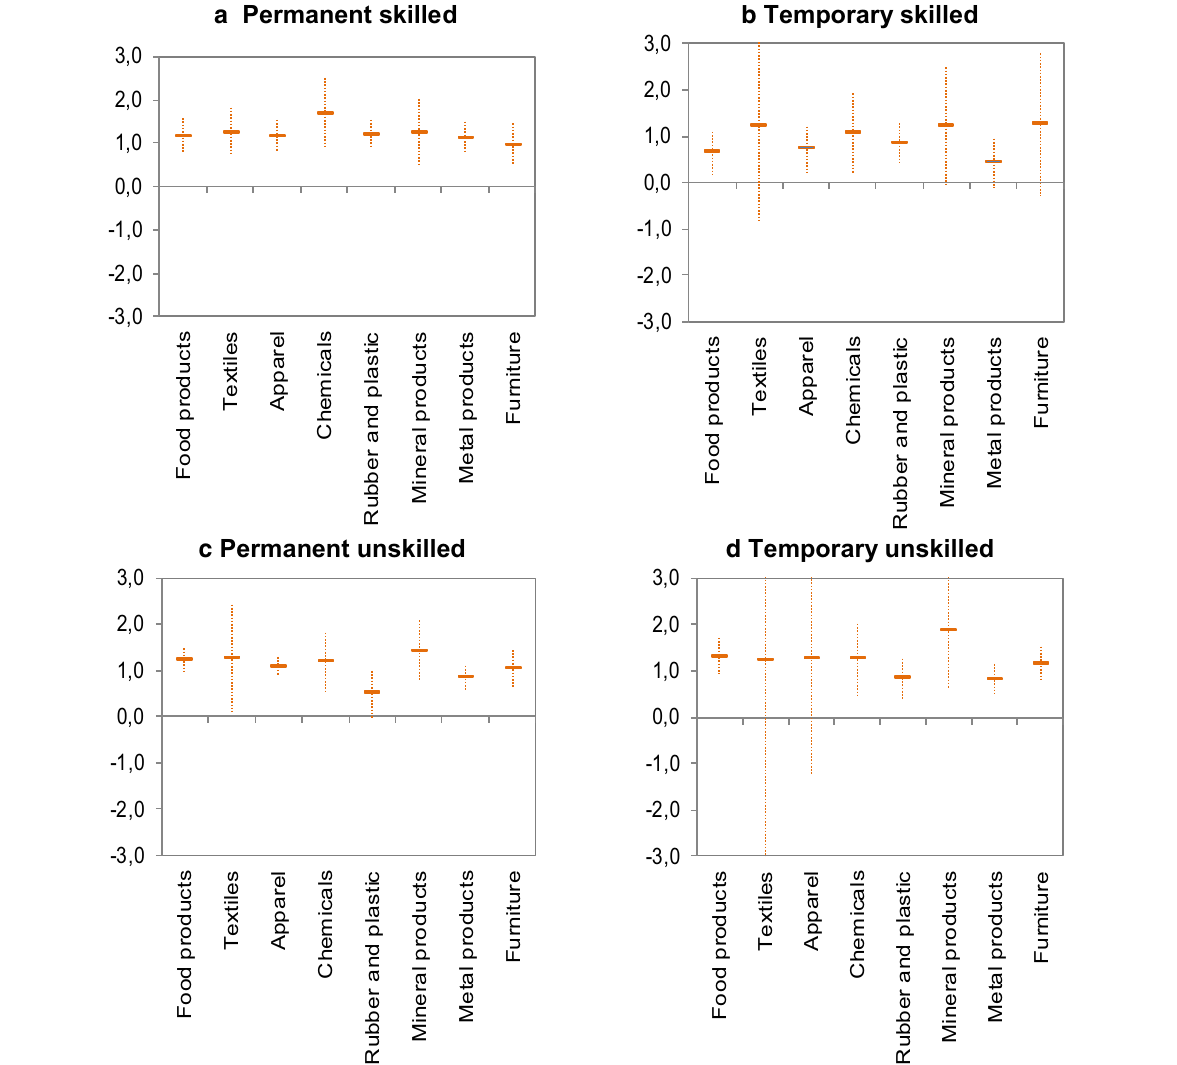
Fig. 8 Long-run output elasticity of conditional labour demand (2000–2013). 95% confidence intervals ( Source Dane-AMS and authors’